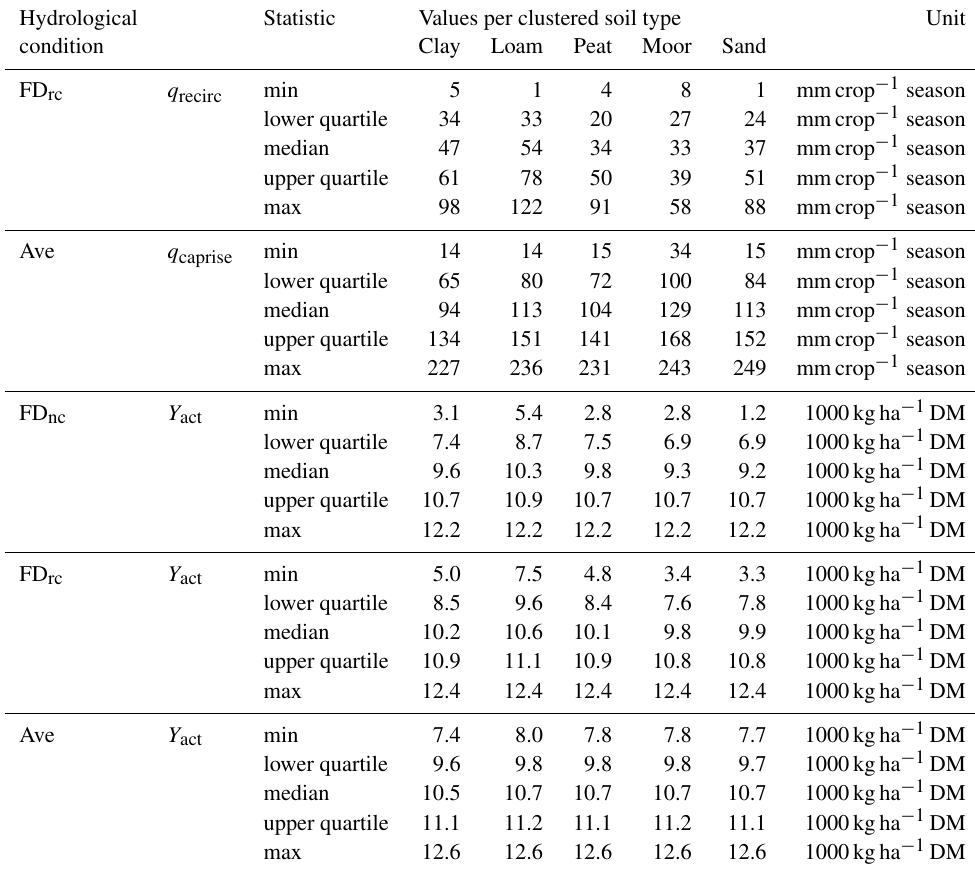
Table 6. Results for potatoes of soil crop experiments for each clustered soil type: capillary rise, recirculation and yield from three different hydrological conditions: FDnc (Free Drainage with No reCirculation), FDrc (Free Drainage with Recirculation) and Ave (Average Drainage conditions). Results for upward flow of FDnc are zero and therefore not